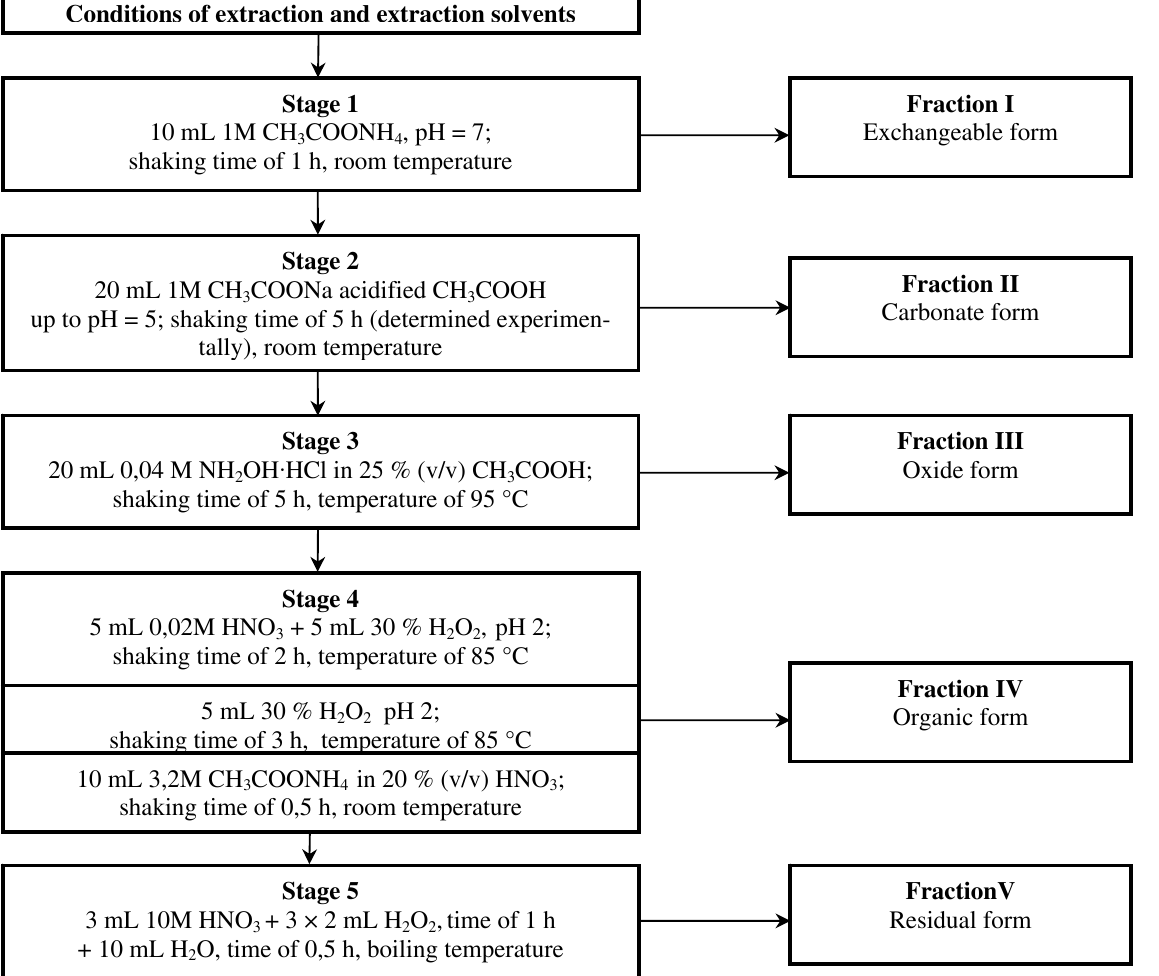
Fig 4. Enzymatic activity of humus horizon in the zone of traffic influence Conditions of extraction and extraction